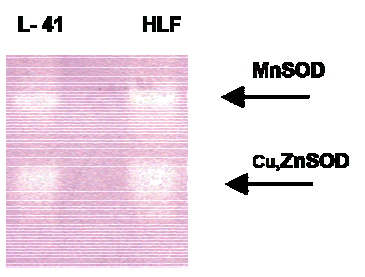
FIGURE 1. The photochemical NBT method of SOD detection in 12% native gel. 50 µg of the total protein has been applied to the